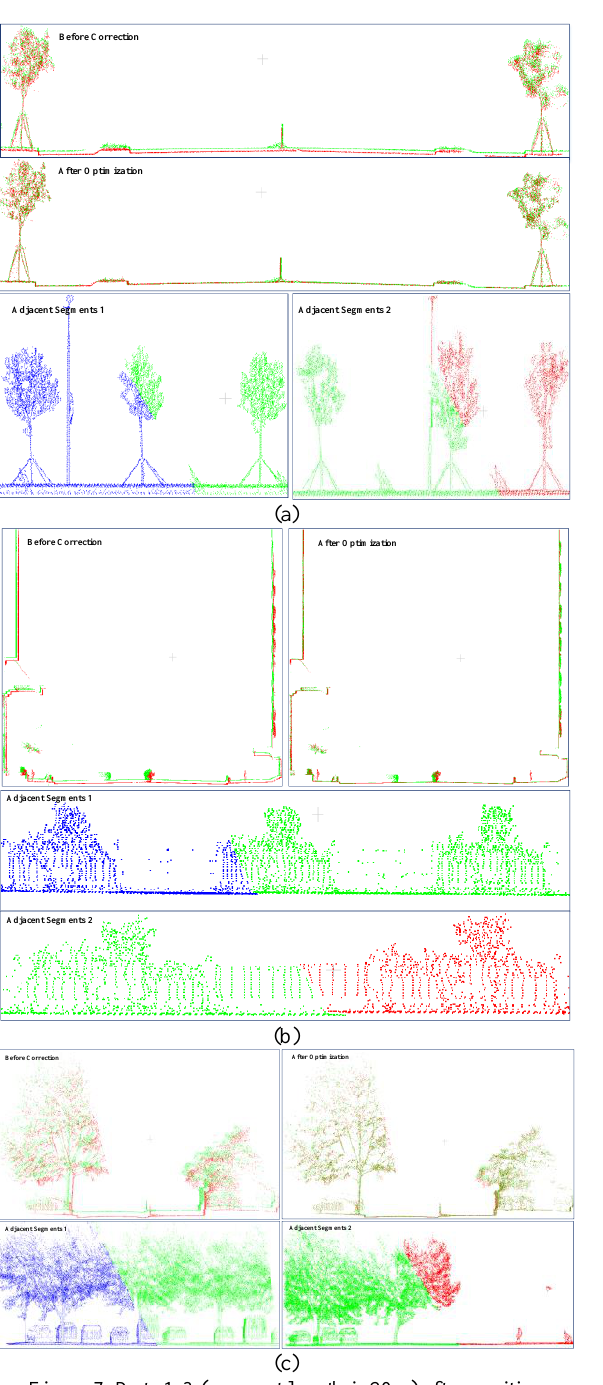
Figure 7. Data 1-3 (segment length is 20m) after position consistency correction. (a) Data 1, (b) Data 2, (c) Data 3. In each sub-figure shows the original point clouds before position inconsistency correction, sectional view after optimization, and sectional view of adjacent segments along the trajectory respectively.